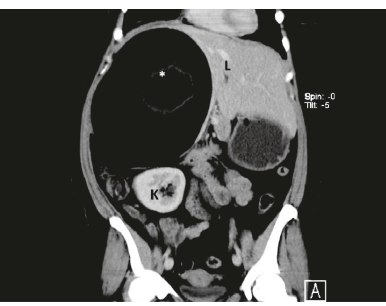
Figure 3: The excised cystic mass has been opened in longitudinal section. Thick yellow fluid has been evacuated from the cyst, leaving hair and sebum visible and small deposits of the bone and cartilage visible within the sac.